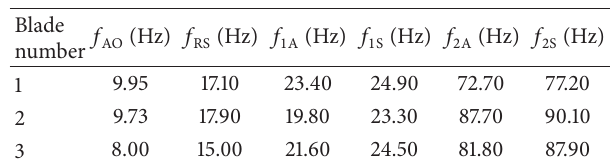
Table 1: Typical second-order following vibration